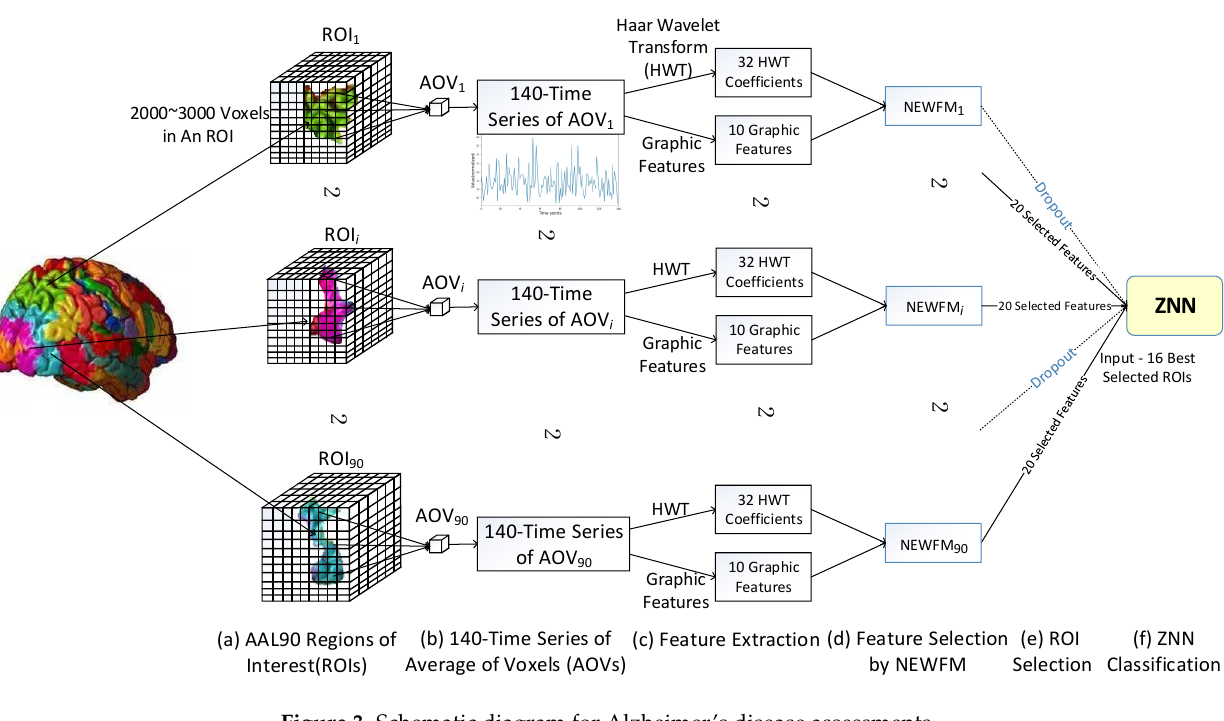
Sensors 2022 , 22 , x FOR PEER REVIEW 8 of 12 Figure 3. Schematic diagram for Alzheimer ’ s disease assessments. Figure 3. Schematic diagram for Alzheimer’s disease assessments.